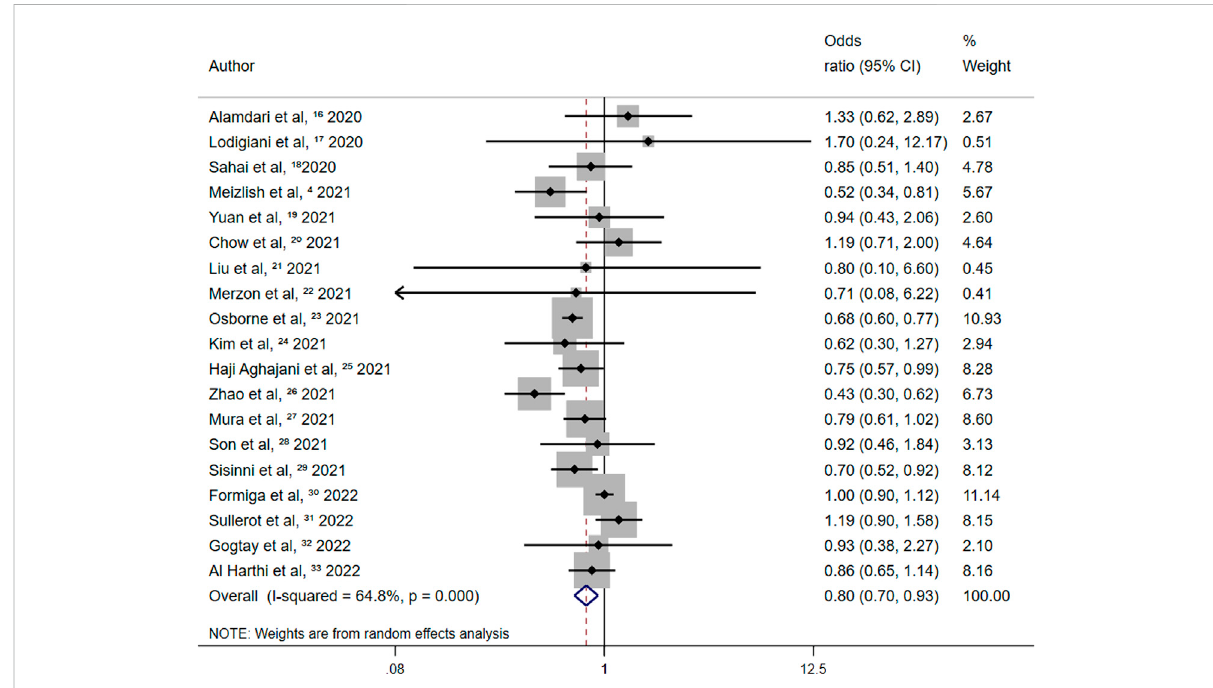
FIGURE 4 Summary odds ratio of all-cause mortality for aspirin use in retrospective studies.